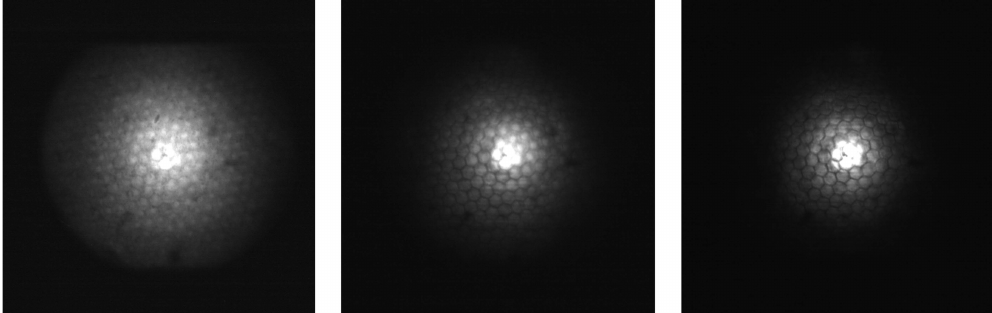
Figure 9 Beam intensity distribution for PC-246 for the primary beam energies 8 keV (left), 12 keV (middle) and 17.5 keV